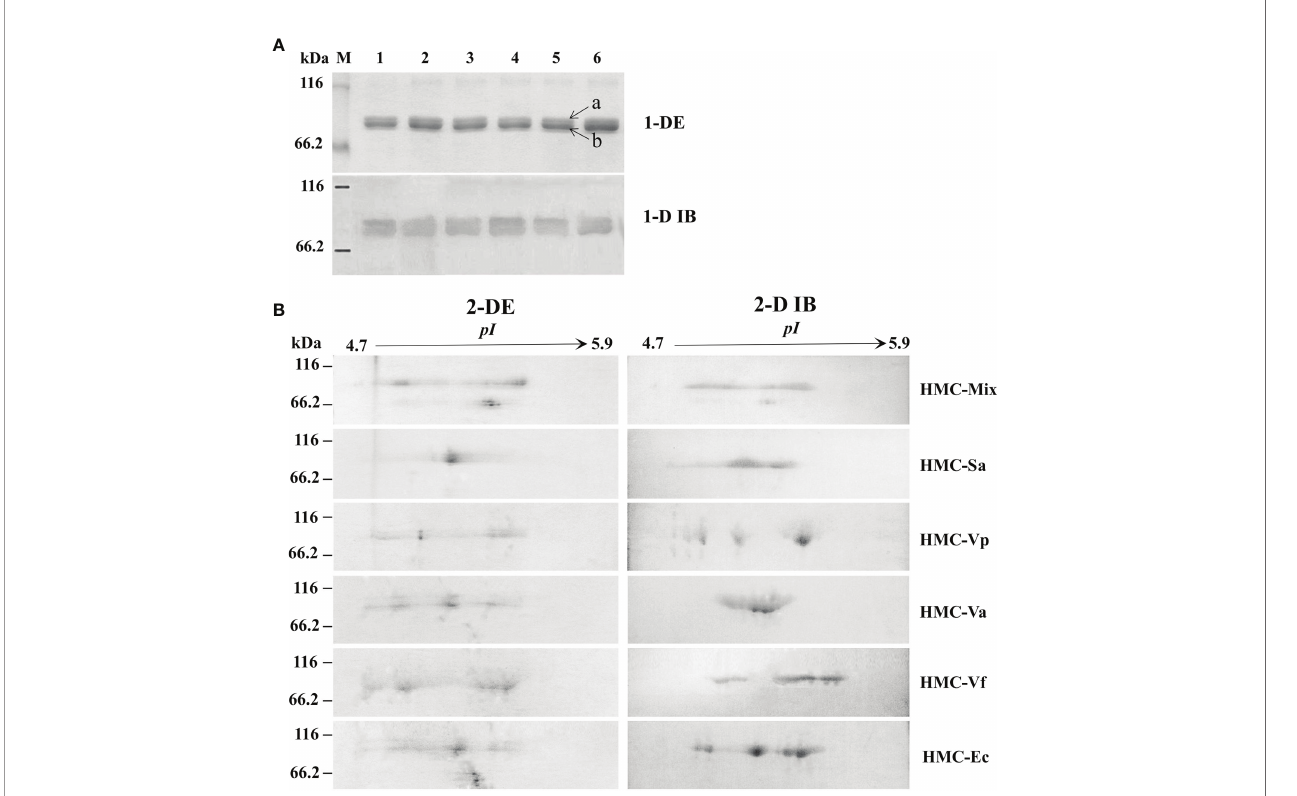
FIGURE 3 | Proteins diversity analysis of six bacteria-binding hemocyanin fractions from L. vannamei . (A) 1-DE and 1-D immunoblotting analysis of six bacteria- binding hemocyanin fractions; 1 – 6, HMC-Mix, HMC-Sa, HMC-Vp, HMC-Va, HMC-Vf, and HMC-Ec, respectively. 1-D IB, 1-D immunoblotting. Bands a and b were identi fi ed by MALDI-TOF-TOF-MS. Western blotting was performed using rabbit anti-shrimp HMC antisera (1:1,000 dilution) and goat anti-rabbit IgG-HRP (1: 3,000 dilution) antibodies. (B) 2-DE and 2-D immunoblotting analysis of six bacteria-binding hemocyanin fractions, i.e., HMC-Mix, HMC-Sa, HMC-Vp, HMC-Va, HMC-Vf, and HMC-Ec. 2-D IB, 2-D immunoblotting. Western blotting was carried out as the same descriptions with (A) .